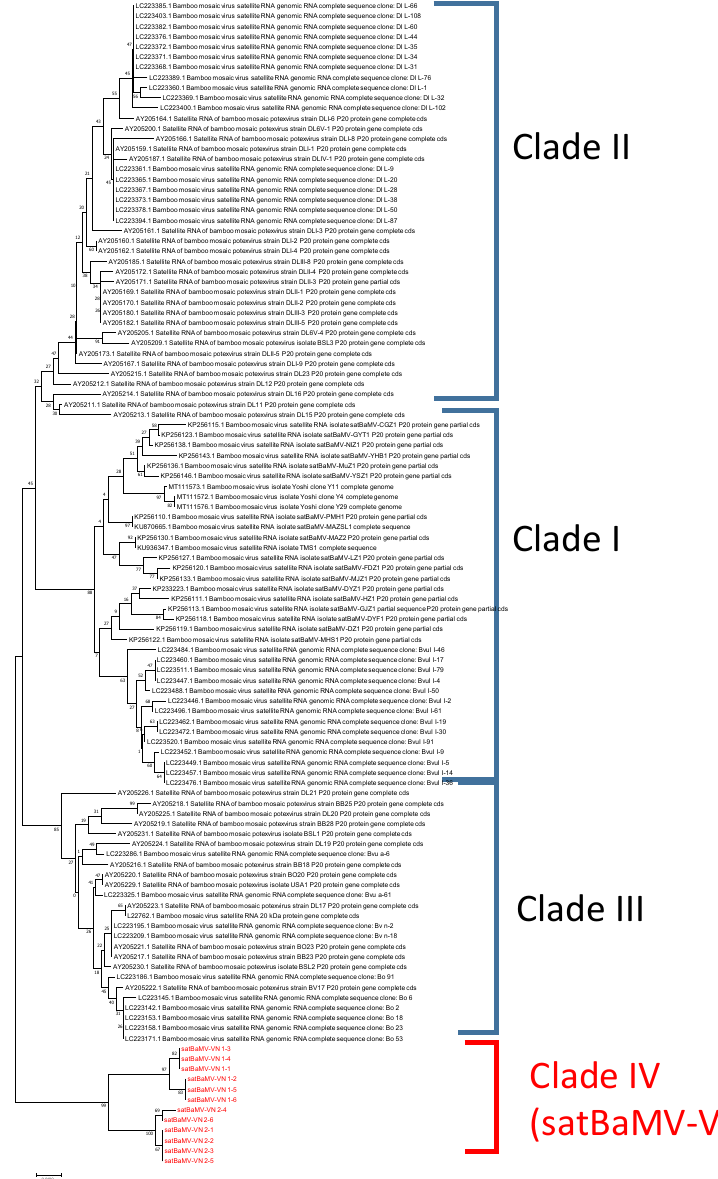
Figure 3. Phylogenetic analysis of satellite RNAs associated with BaMV (satBaMV RNAs). Nucleotide sequences of representative satBaMV RNAs from previous reports [9,10] and those associated with BaMV-VN1 or BaMV-VN2 were subjected to phylogenetic analysis using MEGA X [30], and the phylogenetic tree generated with the neighbor-joining algorithm is shown. The three main clades reported previously plus the clade consisting of the satBaMV RNAs associated with BaMV Vietnam isolates are indicated on the right. The horizontal branches, representing the genetic distances, are drawn to scale. The scale bar at the lower left represents 0.01 substitutions per site. The topology of the tree was evaluated with 100 bootstrap replicates. The percentage of replicate trees that maintain the same clustering in the bootstrap test is indicated on the respective